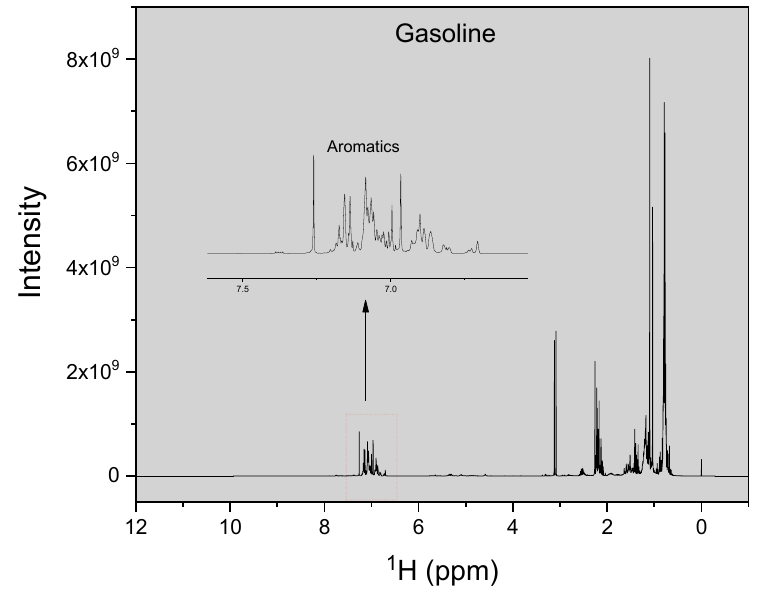
Figure 1. 1 H-NMR spectra of the gasoline sample.